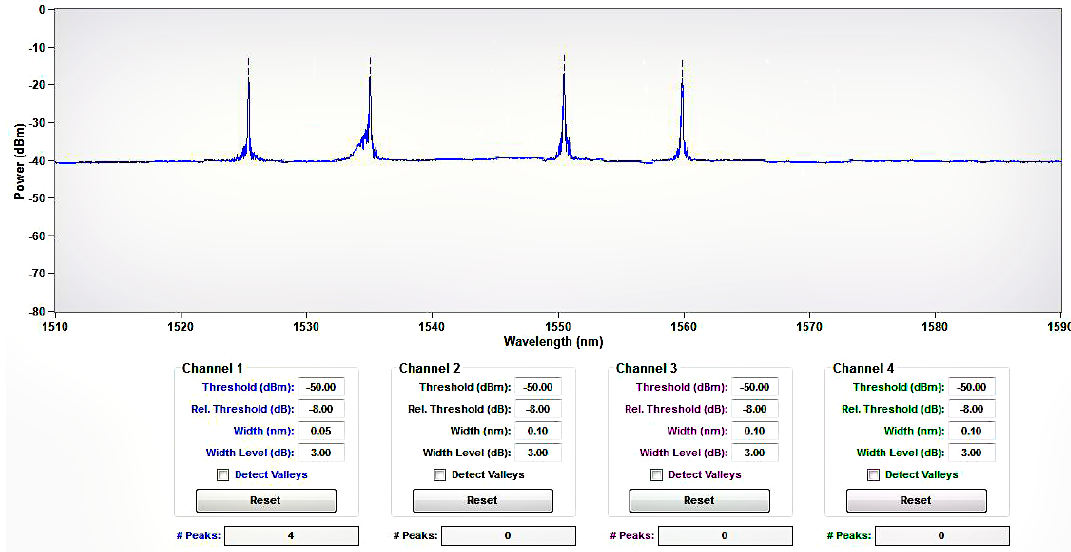
Figure 15. Initial central wavelength distribution of FBG1~FBG4 in Series.